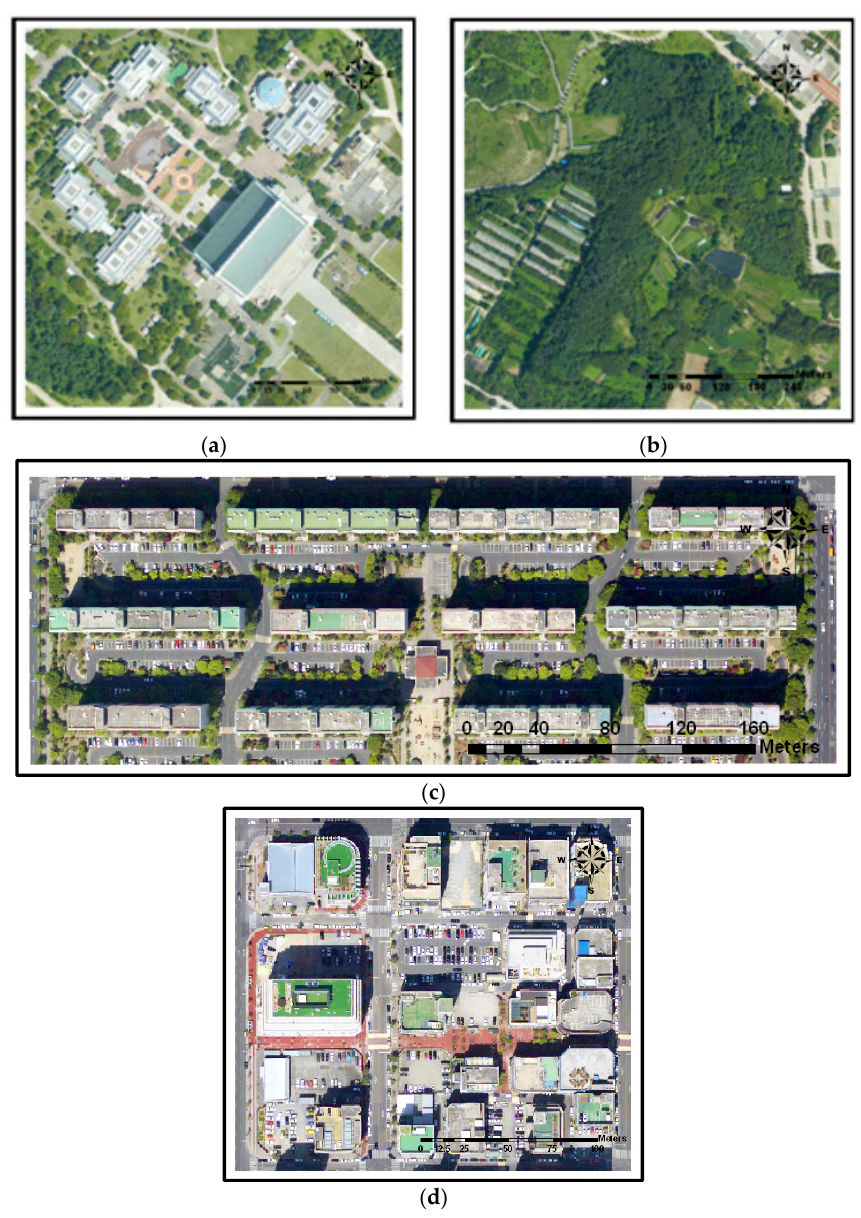
Figure 5. Aerial images of experimental sites: ( a ) site 1; ( b ) site 2; ( c ) site 3; and ( d ) site 4.